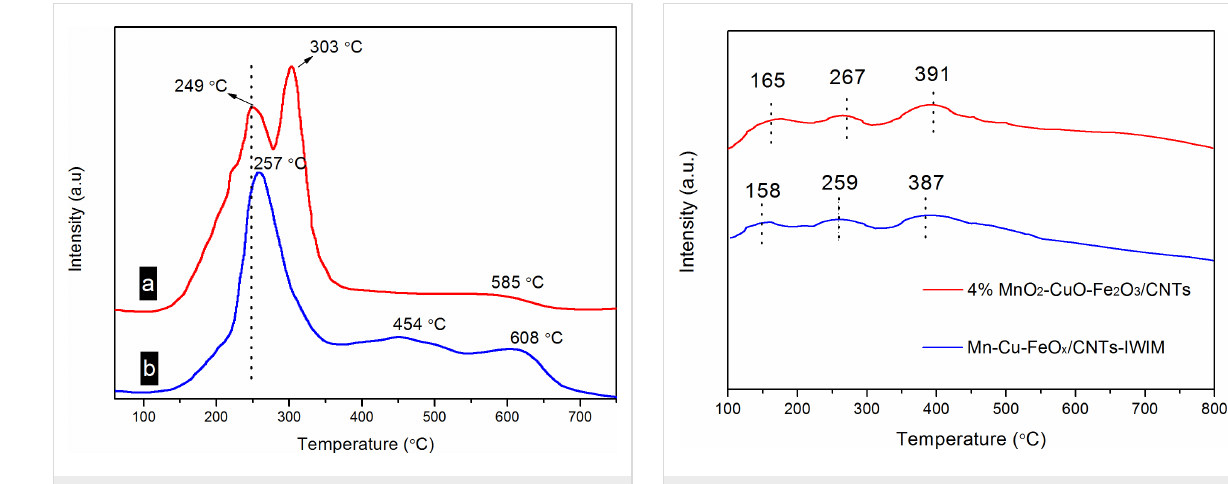
Figure 7: NH 3 -TPD curves of 4% MnO 2 –CuO–Fe 2 O 3 /CNTs and Mn–Cu–FeO x /CNTs-IWIM catalysts.